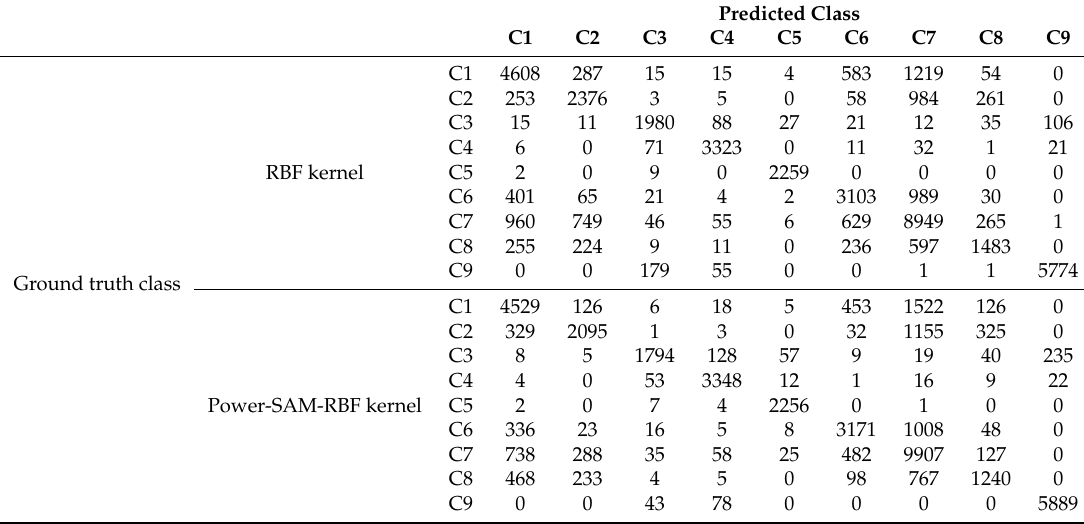
Table 6. Summation of five experimental results in the confusion matrix for the Indian Pines dataset with a proportion of training data of 5%.